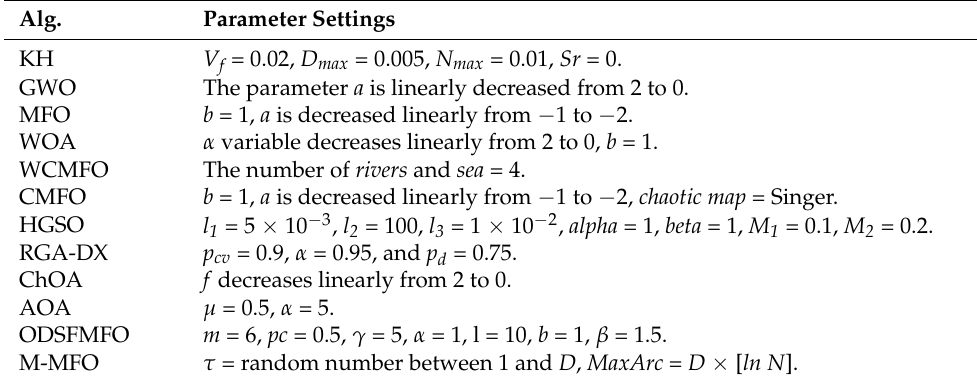
Table 1. Parameter values for the optimization algorithms.